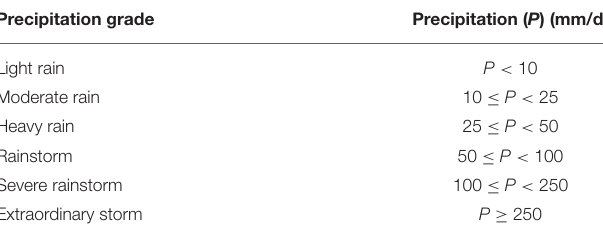
TABLE 1 | Precipitation